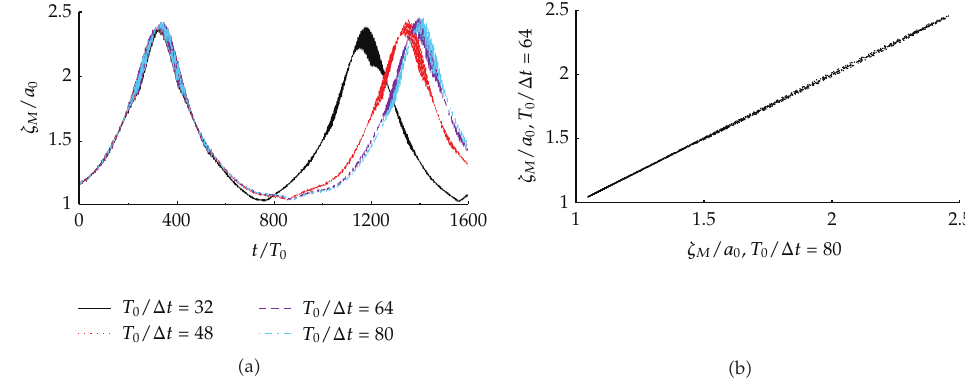
Figure 7: The maximum wave crest histories (cid:2) a (cid:3) and scatter diagram (cid:2) b (cid:3) of Stokes-modulated wave train for ε 0 (cid:7) 0 . 05 , r 1 (cid:7) 0 . 1 , M (cid:7) 4, N (cid:7) 1024 with di ff erent Δ